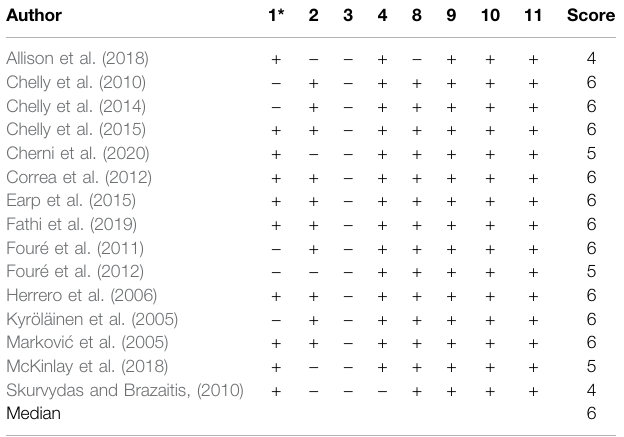
TABLE 3 | Modi fi ed Physiotherapy Evidence Database (PEDro) scores of the reviewed studies.